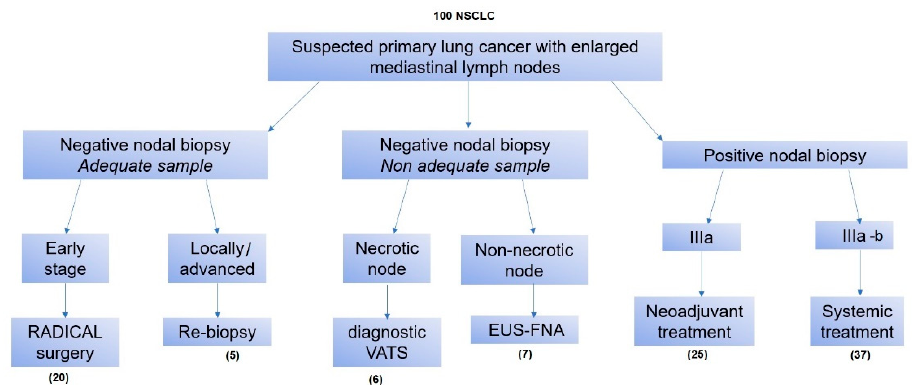
Figure 4. Flow chart of the management of suspected lung cancer with enlarged mediastinal lymph nodes.